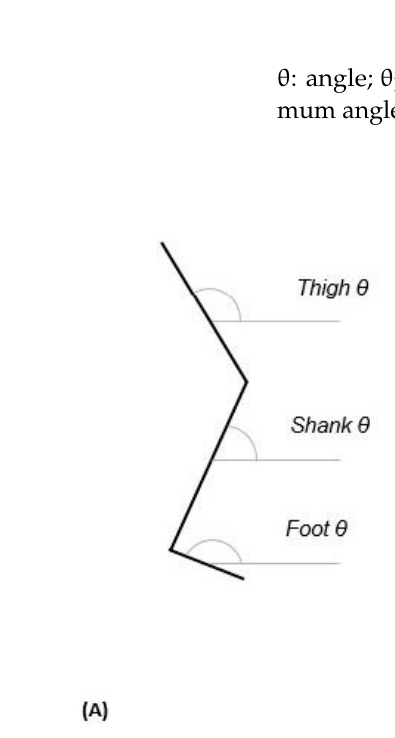
Figure 2. ( A ) Illustration of each segmental angle: thigh, shank, and foot angles in sagittal plane. ( B ) Phase plot illustrating phase angle based on angular displacement versus angular velocity over one gait cycle. Calculation of phase angle ( ϕ ) of thigh was obtained from arctangent function of angular velocity ( ω )/angular displacement ( θ ).